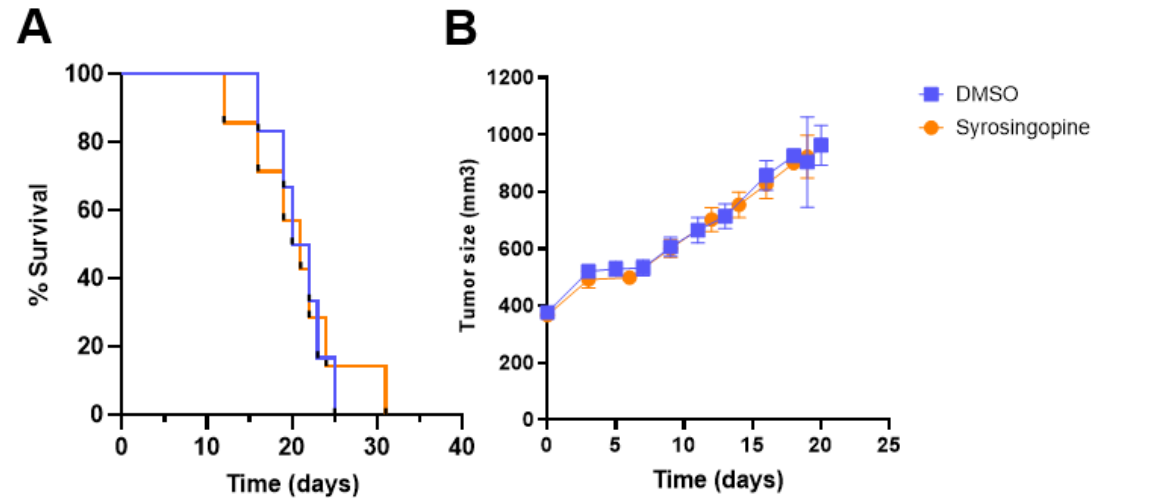
Figure 7. Impact of syrosingopine treatment on tumor growth and survival. ( A ): Evolution of tumor size over time in control (blue) and syrosingopine-treated mice (daily IP injection over 4 days, 5 mg/kg) (orange). ( B ): percentage of survival of mice after treatment with DMSO (control) or syrosingopine for 4 days. Data are represented as mean ± SEM; n = 10 in both groups.